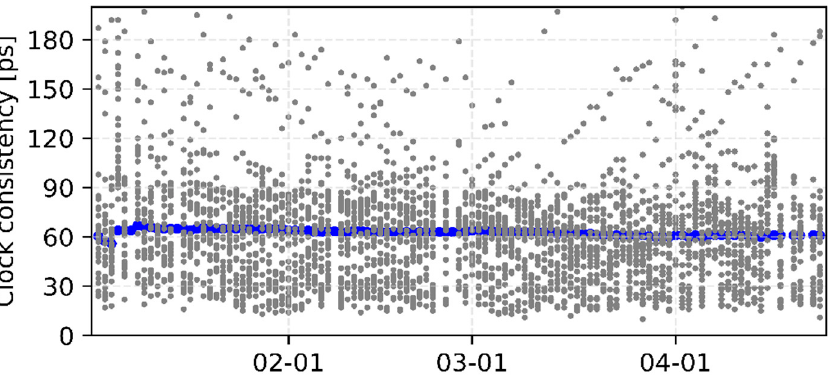
Figure 8. Standard deviations of iGMAS GPS final clocks compared with IGS. The gray circles indicate each GPS satellite for individual day and the blue circles represent the median RMS of all satellites.